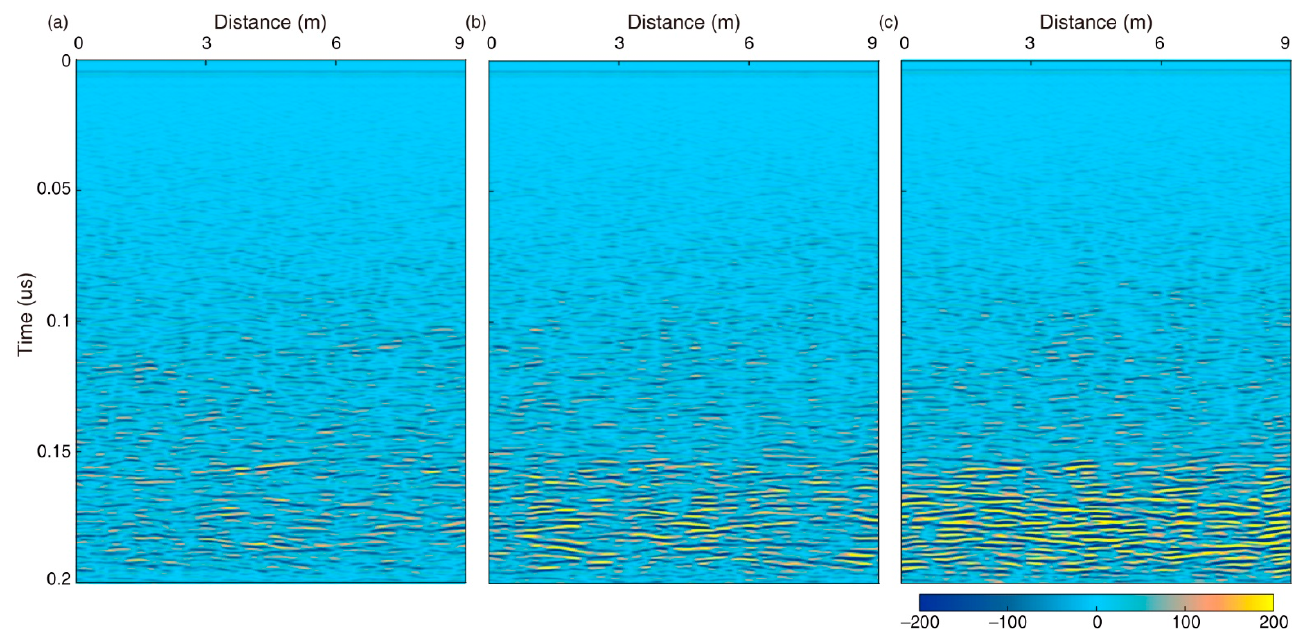
Figure 10. The simulated LPR profiles using the models shown in Figure 9. ( a ) With small spatial density of rocks; ( b ) with medium spatial density of rocks; ( c ) with large spatial density of rocks.